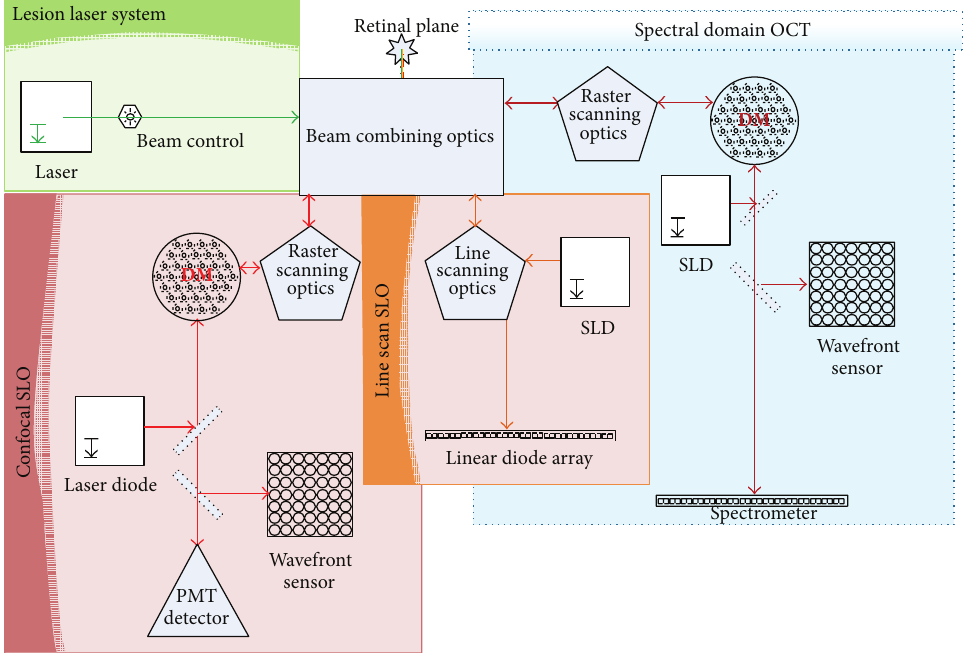
Figure 2: Combined AO cSLO and AO SD-OCT imaging system with wide field line scanning laser ophthalmoscope for collecting complimentary high-resolution images of retinal cross-sections and en face field of